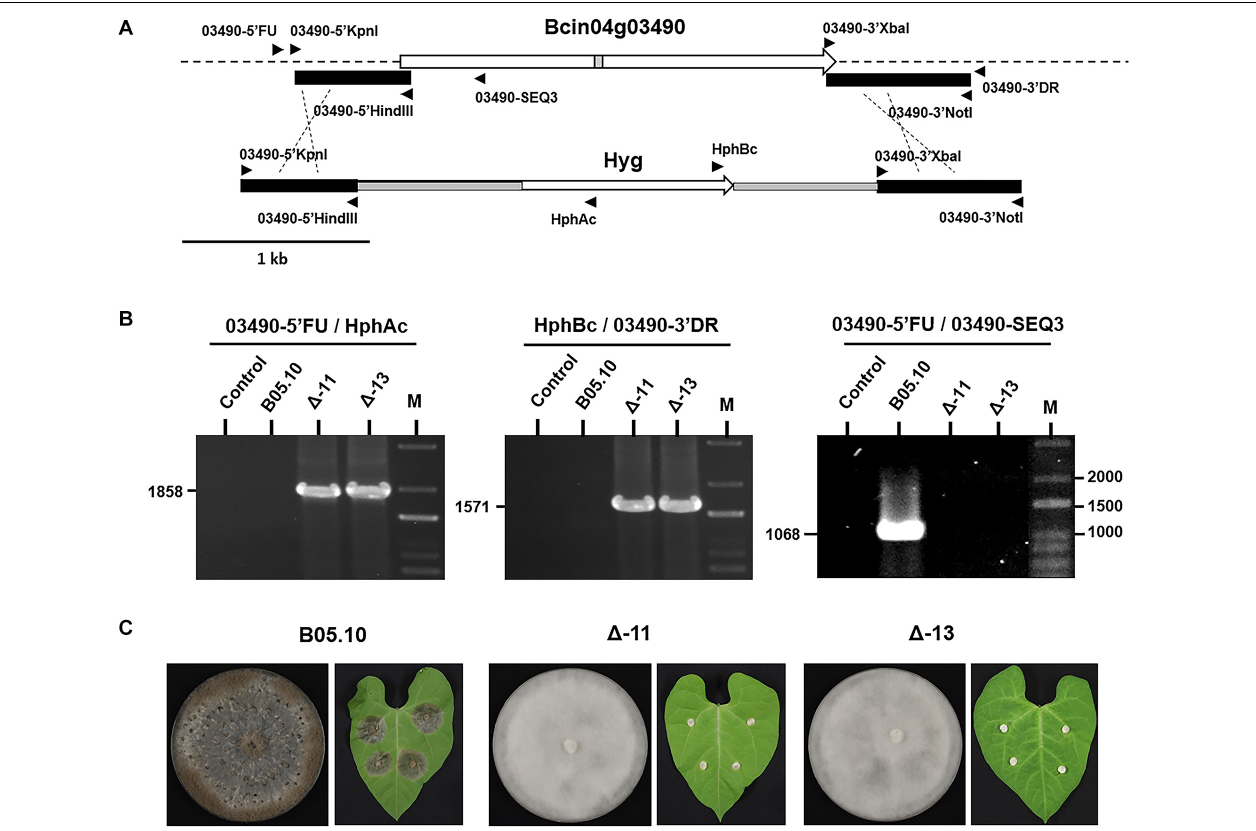
FIGURE 7 | Generation of (cid:49) Bcin04g03490 mutants. (A) Organization of the genomic copy of Bcin04g03490 and structure of the construct used for gene replacement. The flaking sequences conserved to generate the replacement construct are indicated with black boxes. The positions and orientation of the primers used to generate the construct and to confirm the replacement are indicated. (B) PCR based identification of (cid:49) Bcin04g03490 mutants. In all cases reactions were carried out with water (Control), genomic DNA of B05.10 or genomic DNA of two deletion mutants as template. The sizes of the diagnostic bands are indicated. (C) Phenotype of the reference B05.10 isolate and of two deletion mutants during growth in MEA plates (14 days at 22 ◦ C in darkness) and in inoculations in bean leaves (images taken 72 h after